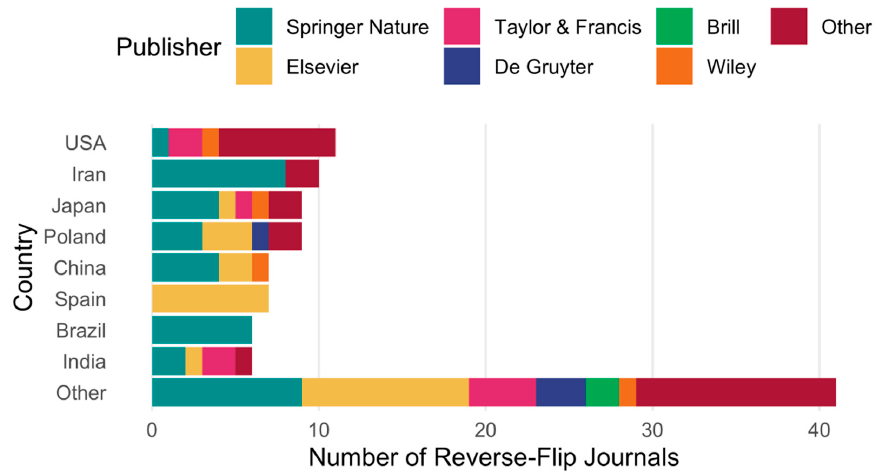
Figure 8. Reverse-flip journals by country of affiliated scholarly society or research institute, grouped by publisher.